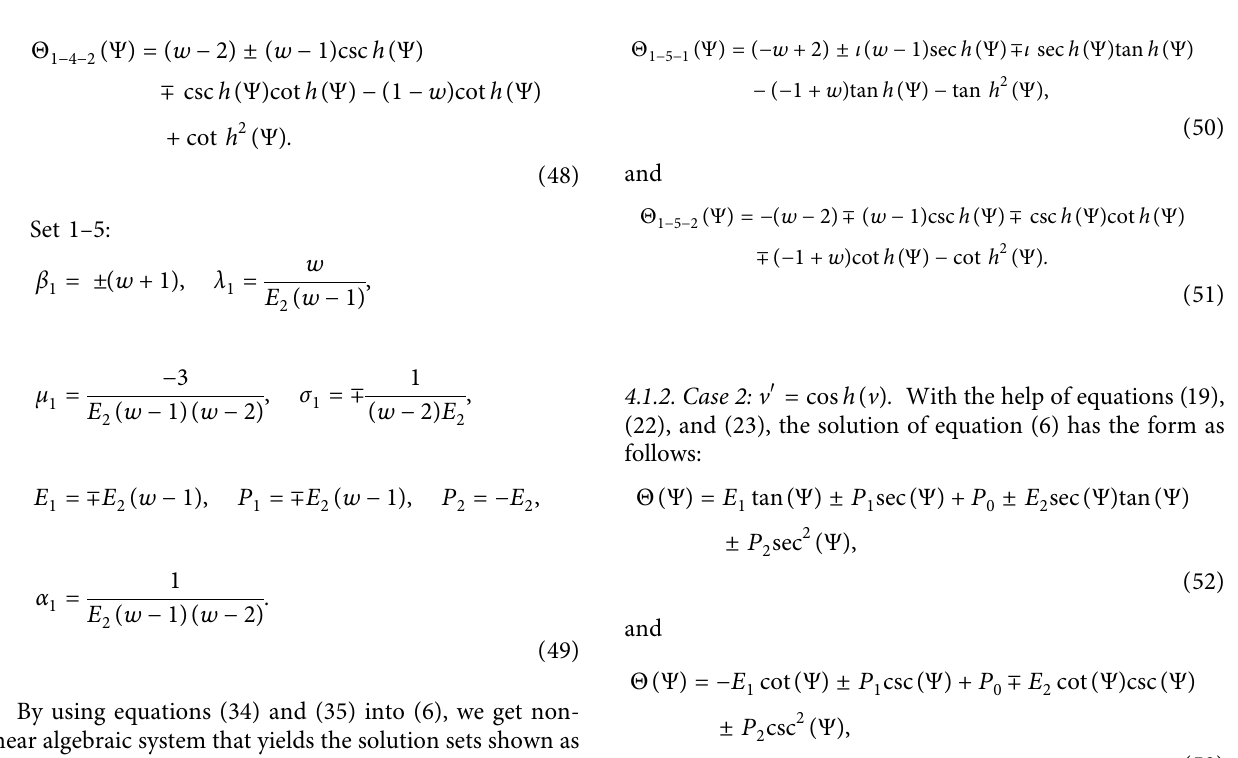
� 0 . 5, and w � 3. (a) Θ 121 , (b) Θ 122 , (c) Θ 121 , Θ 122 1